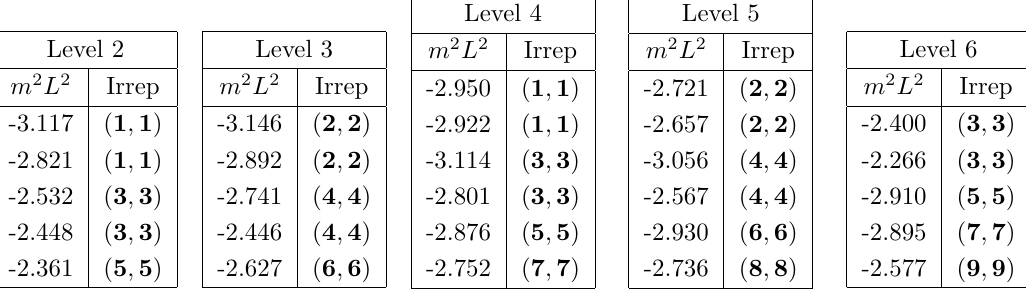
Table 1 . Tachyonic Kaluza-Klein modes, their masses, m , in terms of the AdS length L and their representations under SO(3) (cid:2)